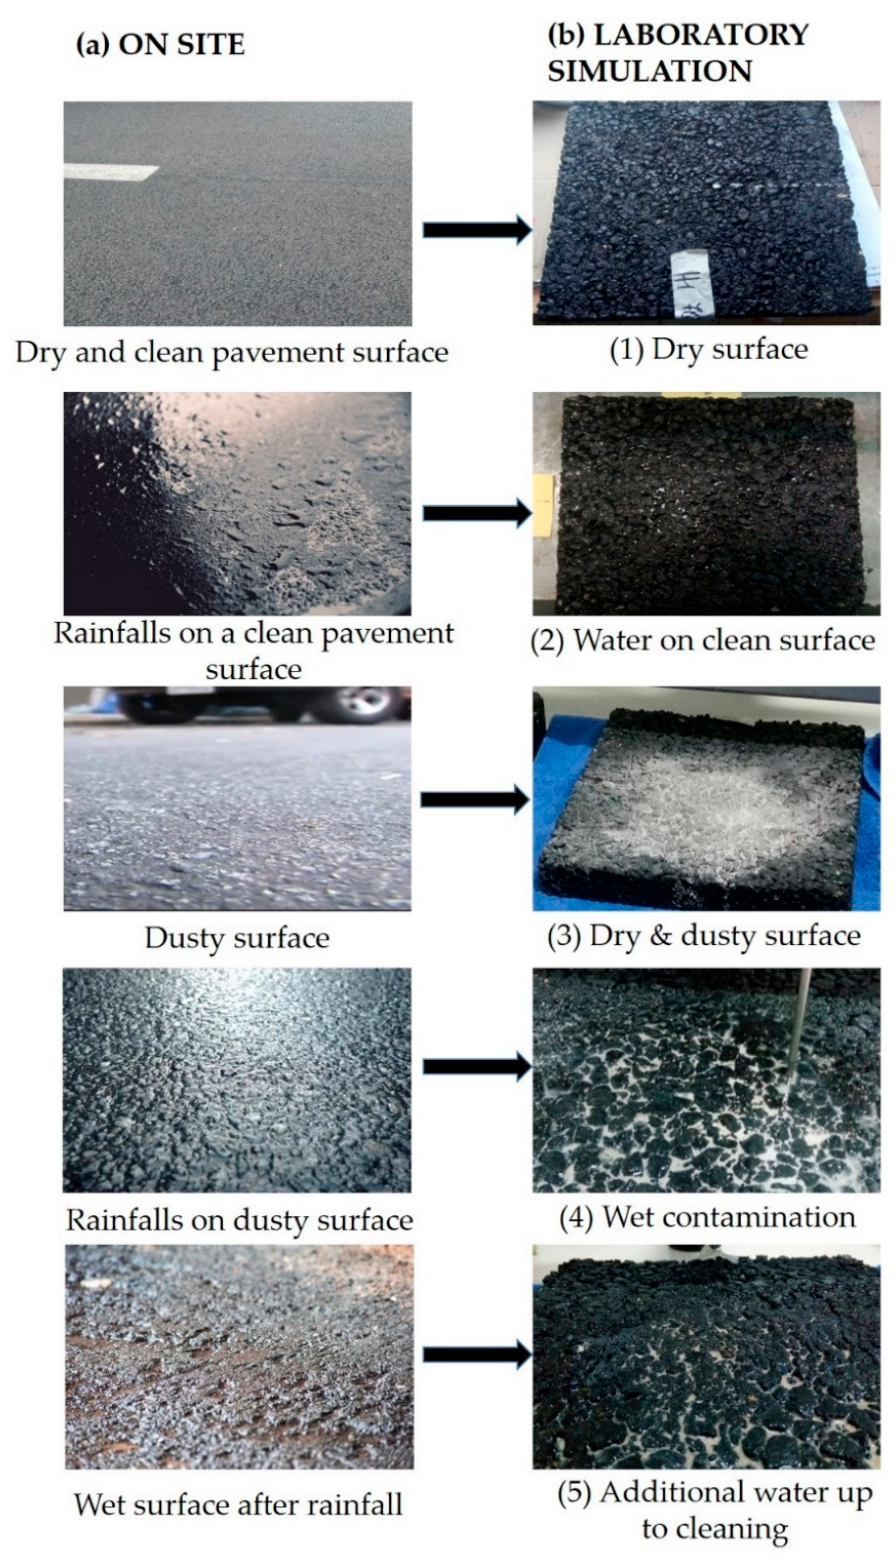
Figure 10. Consideration of various weather conditions: ( a ) on-site status and ( b ) laboratory simu- lations.